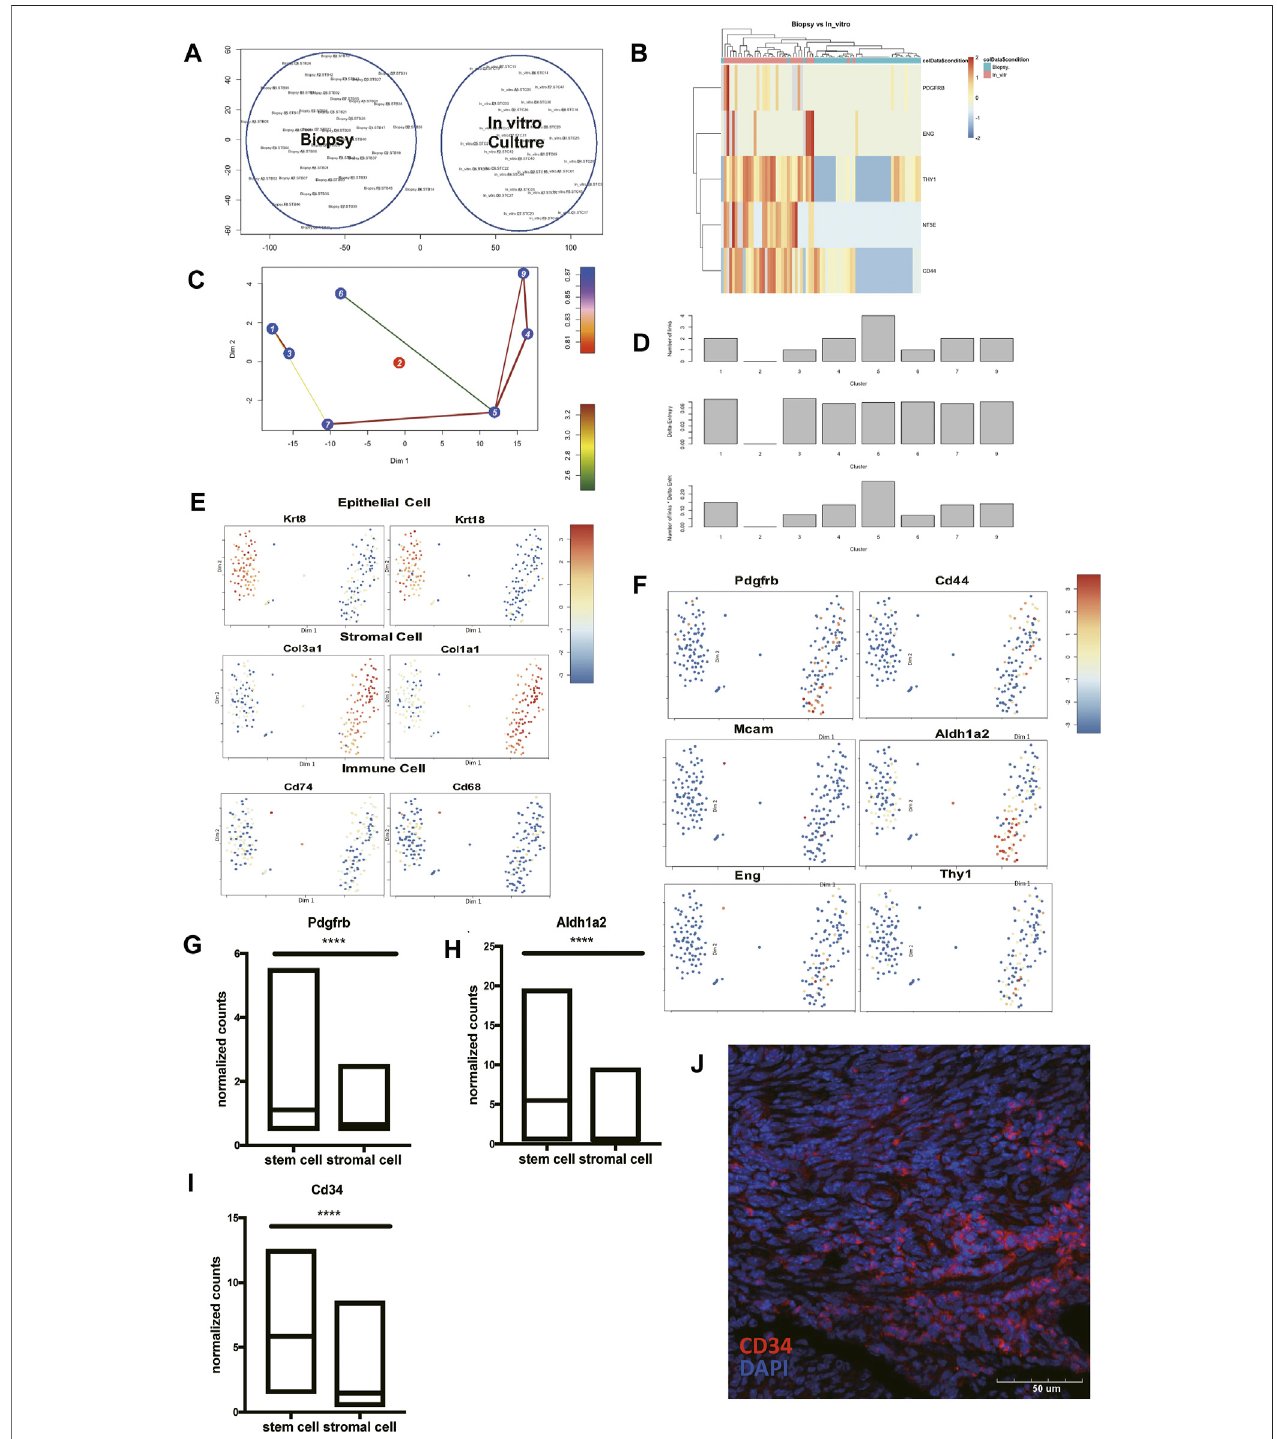
FIGURE 5 | Identify Pdgfrb + Aldh1a2 + Cd34 + endometrial mesenchymal stem cells in vivo . (A) Cells directly harvested from biopsy clustered separately with cells after in-vitro culture. (B) Theheatmappresentedthedifferentiallyexpressed Cd73 ( Nt5e ), Cd90 ( Thy1 ), Cd44 , Pdgfrb ,and Eng incellsdirectlyharvestedfrombiopsyand after in-vitro culture. (C) LineagetreegeneratedbyStemID2. (D) Histograms forthenumber oflinks, thedelta-entropy,andtheStemID2scoregeneratedbyStemID2.A high score indicates a higher likelihood that the cluster is an actual stem cell cluster. The t-SNE map with color code representation of log-transformed expression across marker genes of (E) epithelial cells, stromal cells, immune cells, and (F) stem cells. (G – I) The expression level of Pdgfrb, Aldh1a2, and Cd34 in cluster 5 and the rest of the uterine stromal cells. (J) Representative IF staining of CD34 expression levels in mice endometrium. (DAPI, blue; CD34, red). Scale bars, 50 μ m. IF: immuno fl uorescence; p -value <